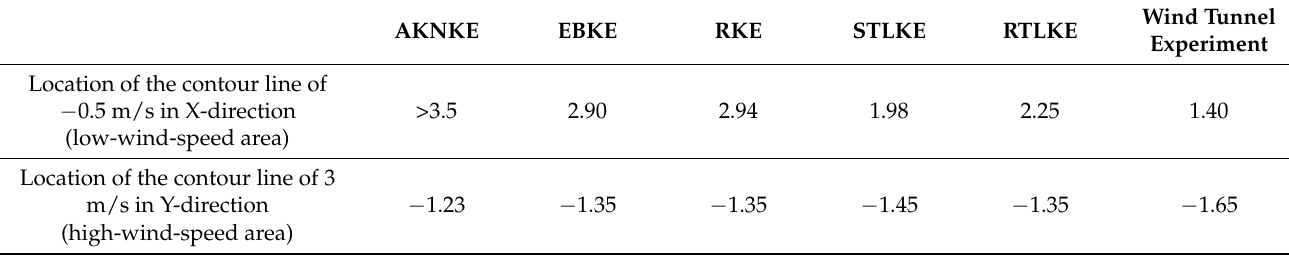
Figure 11. Contour plots of X-velocity ( U ) at z/b = 0.125. Table 6. Location of contour line at z/b = 0.125 ( U ).